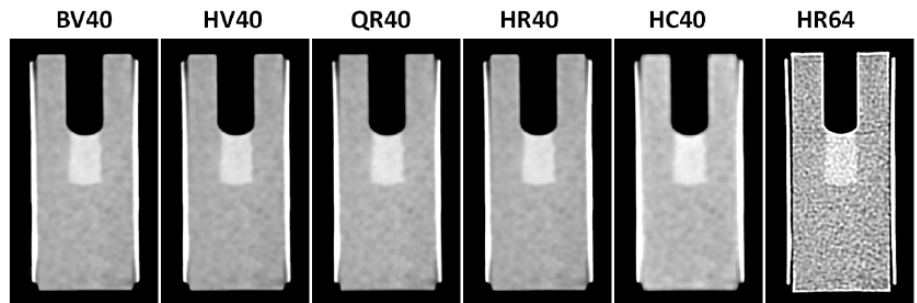
Figure 5. The iodine loaded phantom imaged at 80kVp in the Siemens SOMATOM go.Up CT scanner, reconstructed using all available reconstruction kernels. Ranked from highest performing ( left ) to lowest performing ( right ).